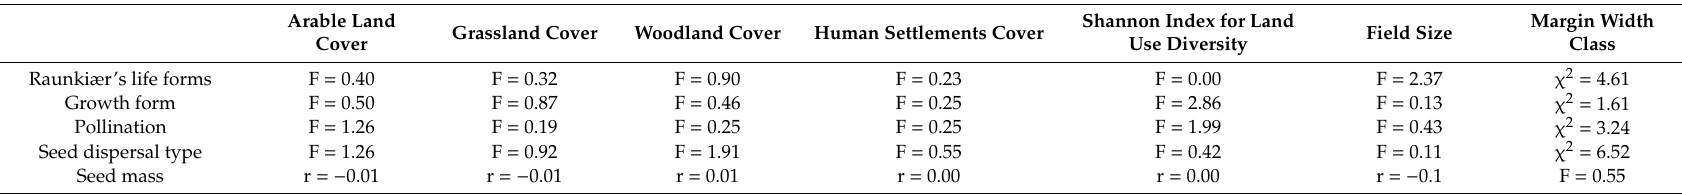
Table 4. Relationships between functional traits and intensification variables provided by the fourth-corner analysis. None of the relationships were significant ( p > 0.05 in all